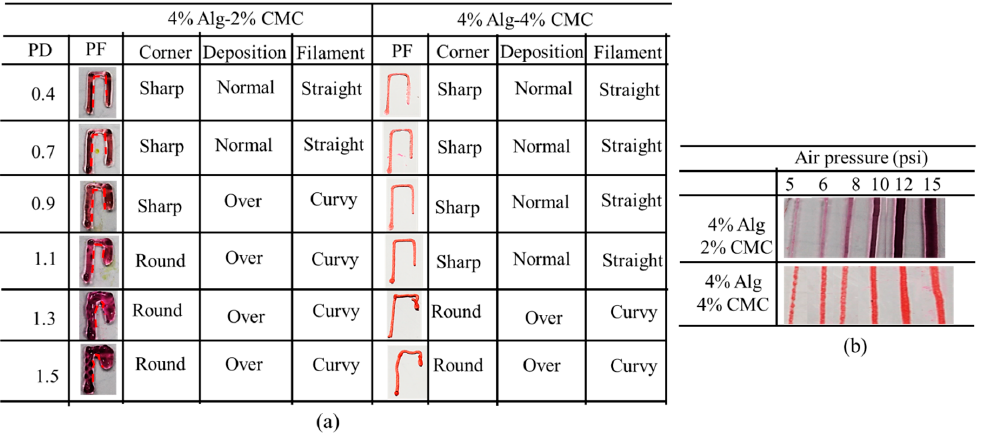
Figure 14. Qualitative effect of ( a ) print distance, ( b ) air pressure.